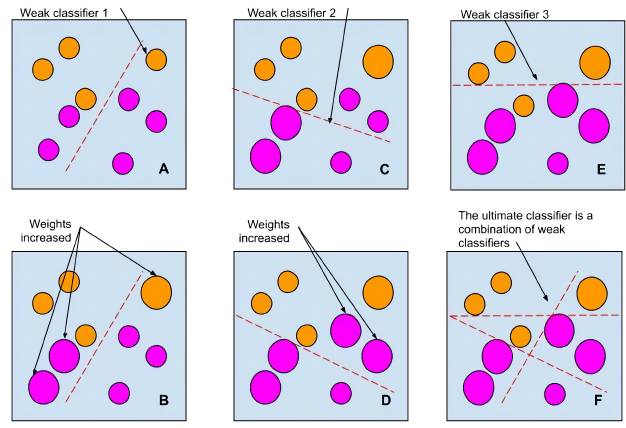
Figure 5. The process of the combination of the ultimate strong learner in AdaBoost Majority Weighted Minority Oversampling Technique (MW- MOTE). MWMOTE [42] balances the class distribu- tion also by generating synthetic examples from